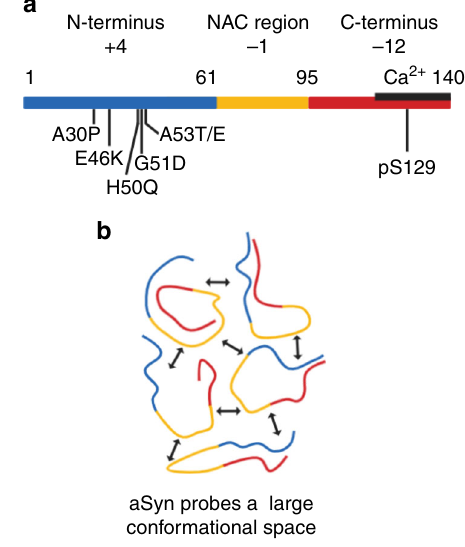
Fig. 1 Representation of the regions of monomeric aSyn. a Monomeric aSyn is de fi ned by three regions, the N-terminus, residues 1 – 60 (blue) with an overall charge of + 4, contains the familial mutations A30P, E46K, H50Q, G51D, A53E and A53T. The non-Amyloid- β component (NAC) region, residues 61 – 95 (yellow), has an overall charge of − 1, is highly hydrophobic and forms the core of fi brils. The C-terminus, residues 96 – 140 (red), is highly negatively charged with an overall charge of − 12. Residue S129 is commonly phosphorylated (pS129) in Lewy bodies, but rarely in its soluble state. The calcium binding region (black line) is also found at the C- terminus and spans residues 115 – 140. b Monomeric aSyn is highly dynamic and visits a large conformational space. Transient intramolecular interactions between the N-terminus (blue) and C-terminus (red) and NAC region (yellow) maintain it in a soluble form. Created with